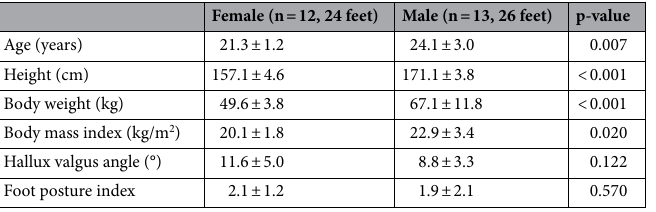
Table 1. General characteristics of healthy subjects. Data are shown as mean ± standard deviation.